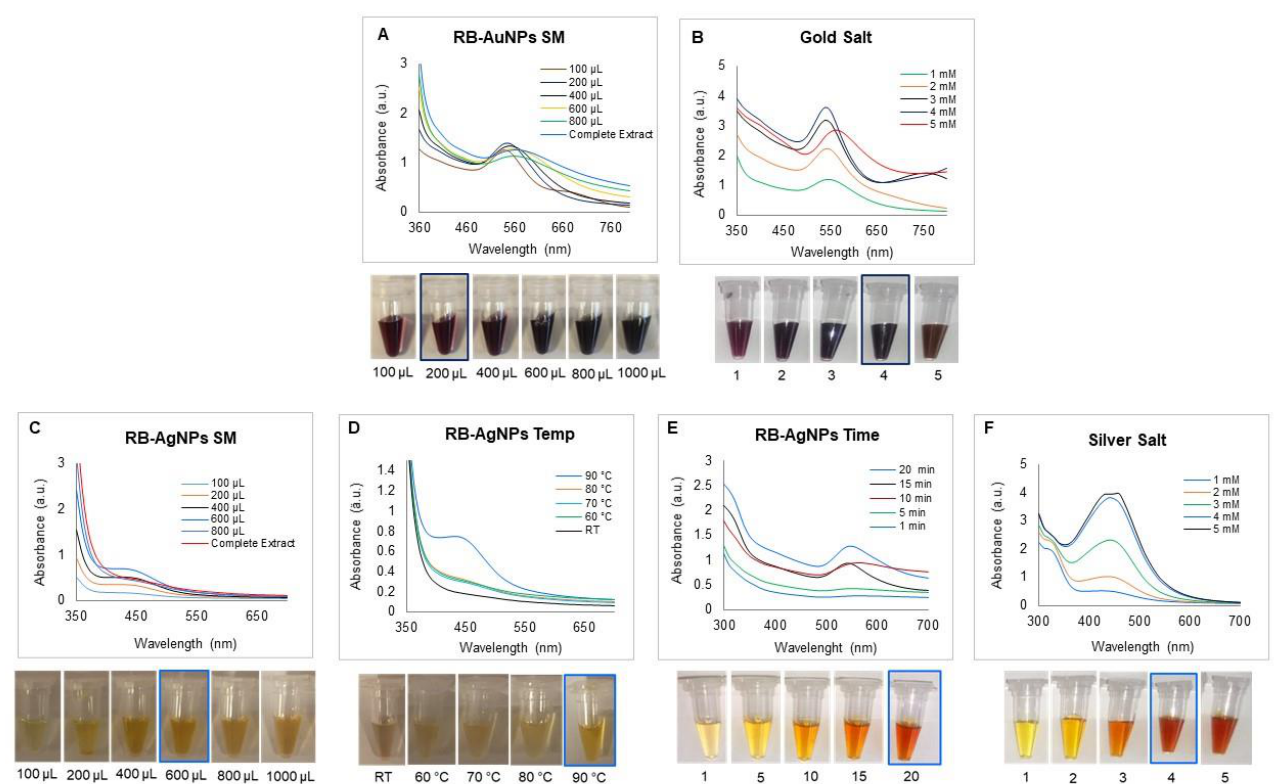
Figure 2. Optimization studies for RB-AuNPs and RB-AgNPs production. For RB-AuNPs produc- tion, visible picture and UV-Vis spectrum ( A ) synthesis medium (SM) optimization, ( B ), gold salt optimization. For RB-AgNPs production, visible picture and UV-Vis spectrum ( C ) synthesis medium (SM), ( D ) temperature, ( E ) synthesis time, ( F ) silver salt concentration.